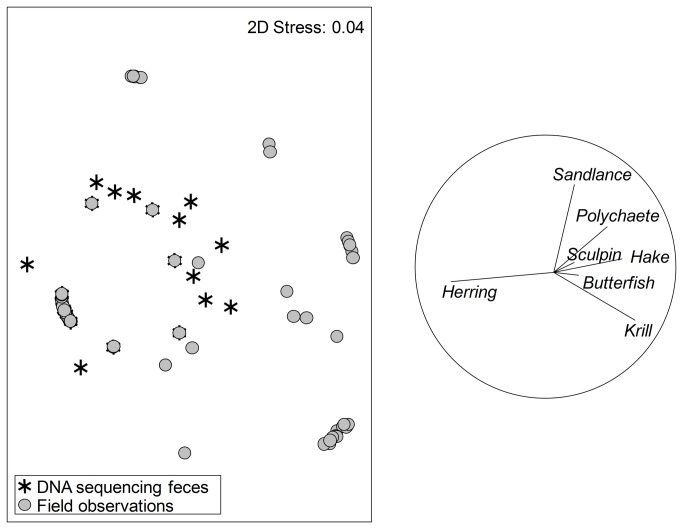
Non-metric multidimensional scaling (MDS) plots depicting differences in prey assemblage of chick diet through DNA and field observations.Grey circles represent a single feeding delivery to a puffin chick. Stars represent individual chick fecal samples. Vectors are the correlations between prey types (herring, sandlance, polychaete, sculpin, hake, butterfish, and krill) and the MDS axes where vector length and direction reflects taxon frequency. See caption on Figure 5 for more explanations on MDS plots and vector overlays.